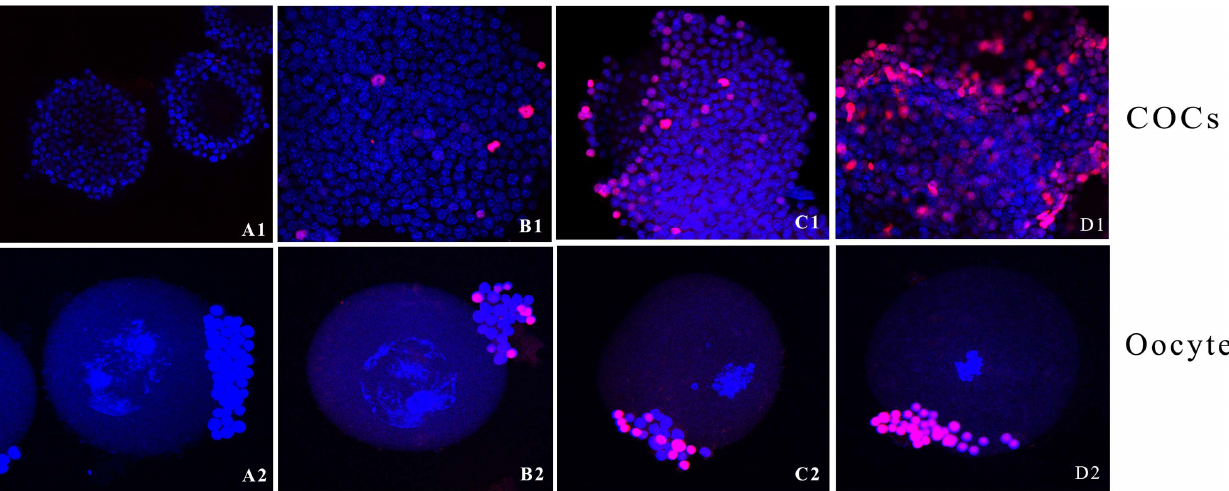
Figure 4. Representative images of cumulus-oocyte complexes and oocytes after exposure to Aroclor 1254 subjected to TUNEL analysis. COCs and oocytes representative samples from (A1 and A2) the control group, (B1 and B2) the 12.5 mg/kg Aroclor 1254-treated group, (C1 and C2) the 25 mg/kg Aroclor 1254-treated group, and (D1 and D2) the 50 mg/kg Aroclor 1254-treated group for TUNEL analysis are shown. Red staining indicates fragmented DNA in cumulus cells undergoing apoptosis, whereas intact cell nuclei are stained blue respectively.